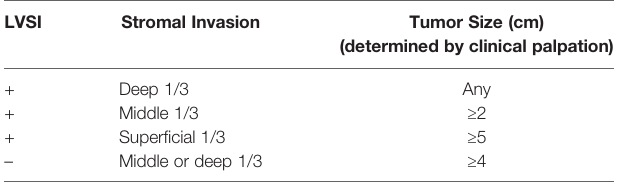
TABLE 1 | Sedlis Criteria for external pelvic radiation after radical hysterectomy in node-negative, margin-negative, parametria-negative cases.